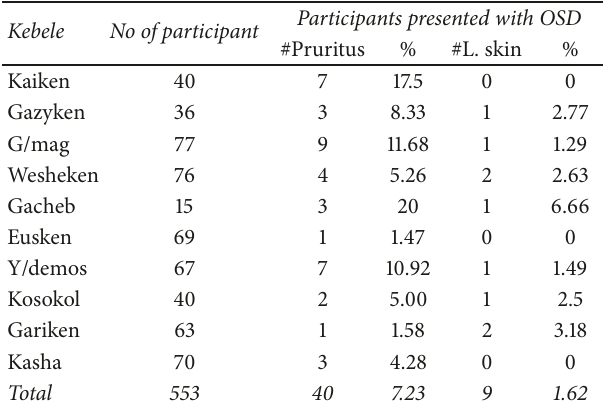
Table 3: Prevalence of clinical presentation onchocerciasis skin disease, Semen Bench district, Bench Maji Zone, June 2018